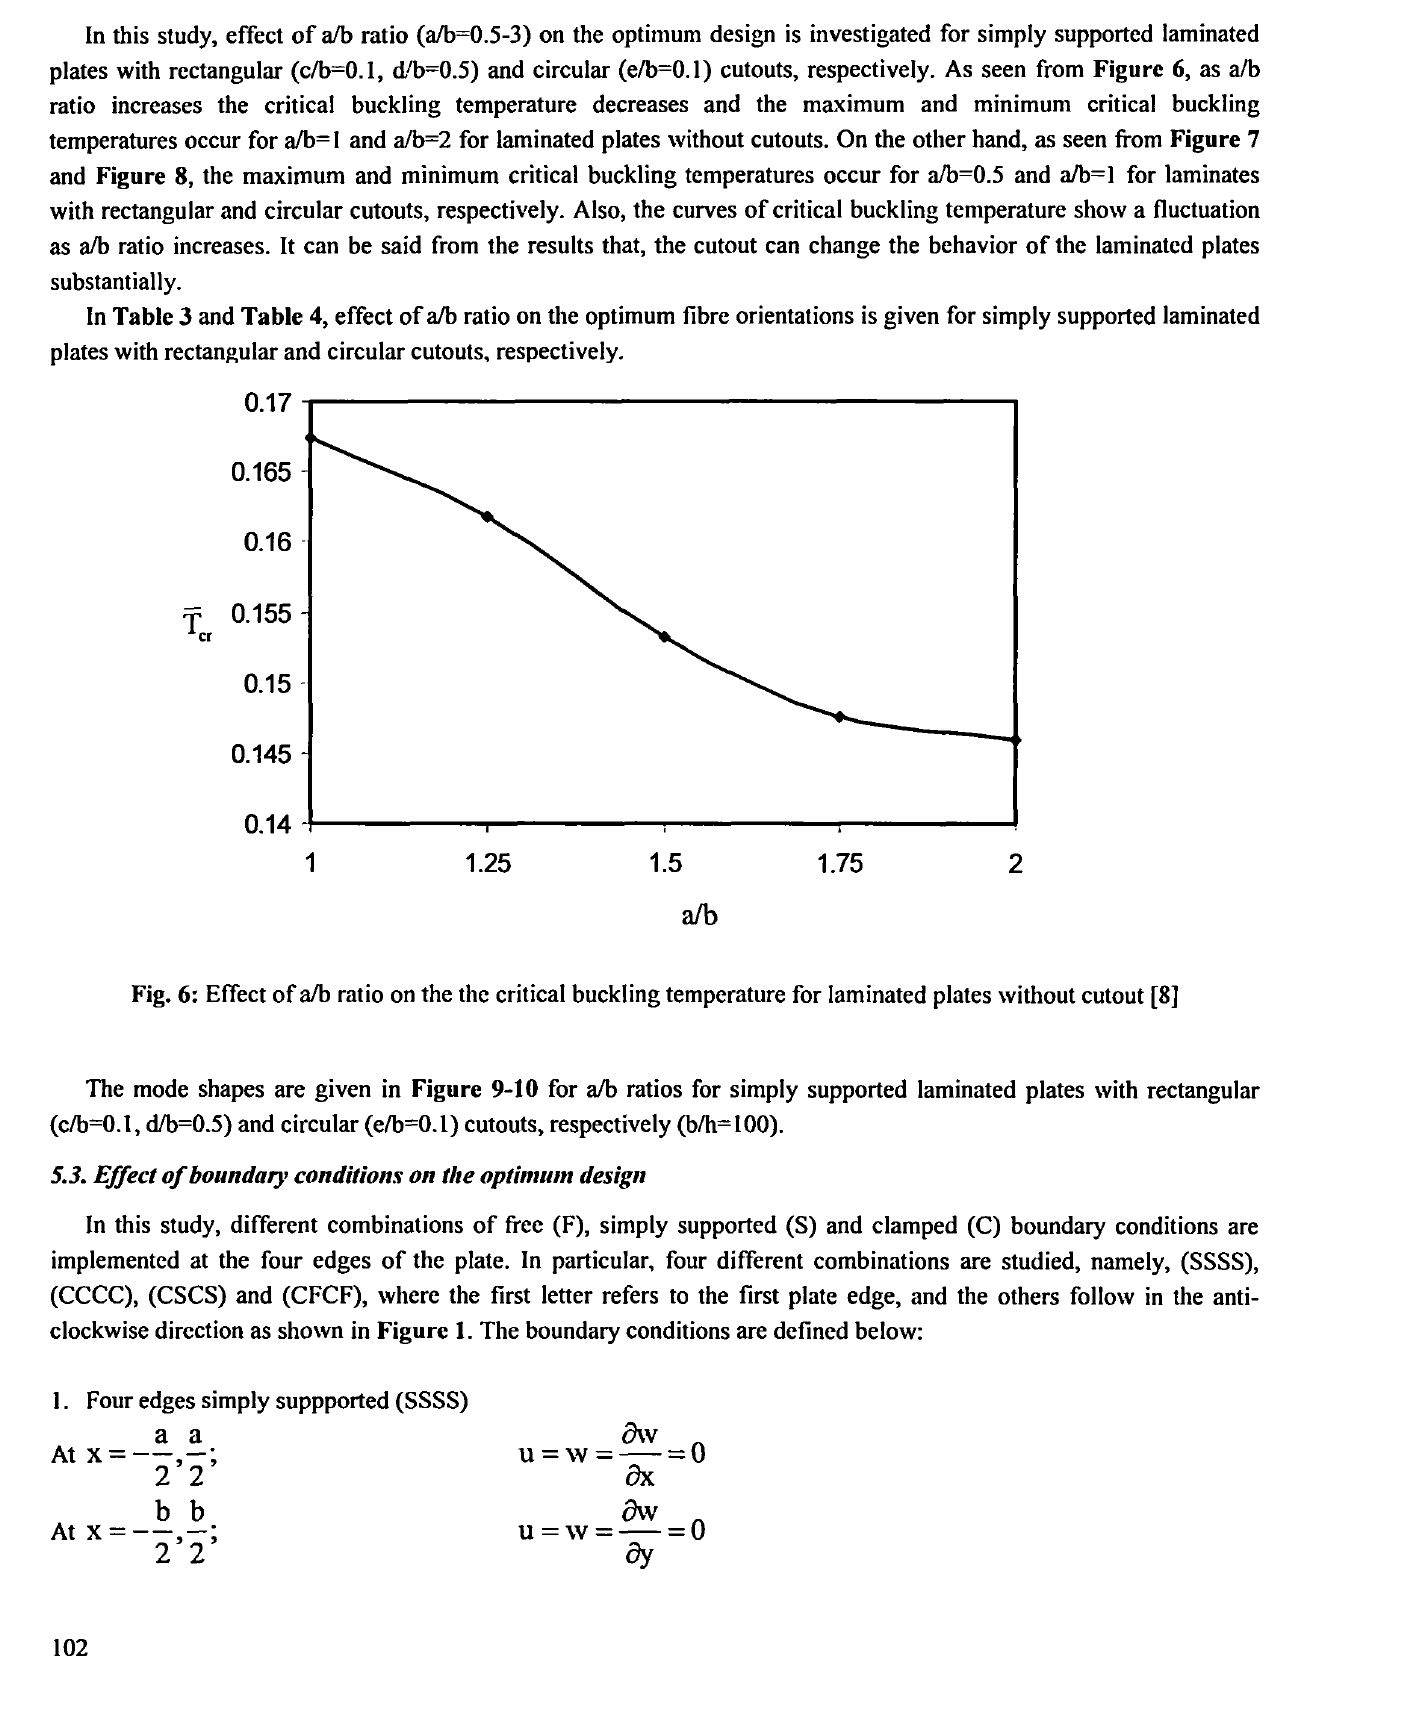
The mode shapes are given in Figure 9-10 for a/b ratios for simply supported laminated plates with rectangular (c/b=O.I, d/b=0.5) and circular (e/b=0.1) cutouts, respectively